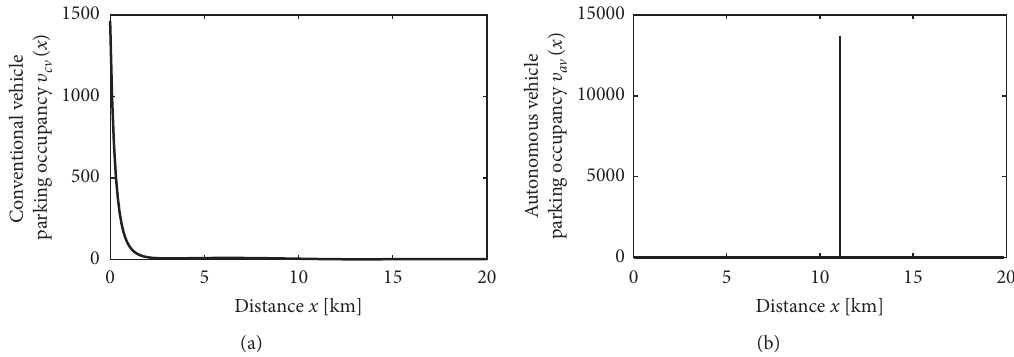
Figure 13: (a) Parking occupancy of conventional vehicles and (b) parking occupancy of autonomous vehicles.